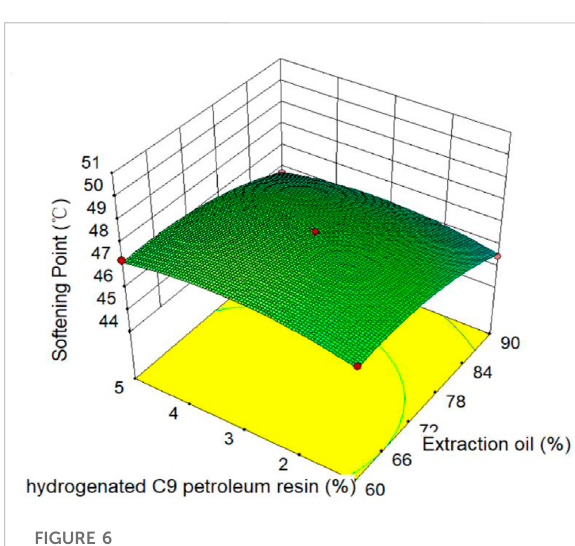
FIGURE 6 Extracted oil with hydrogenated C9 petroleum